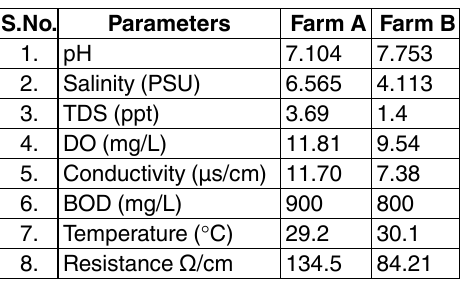
table 4. Physico-chemical parameters